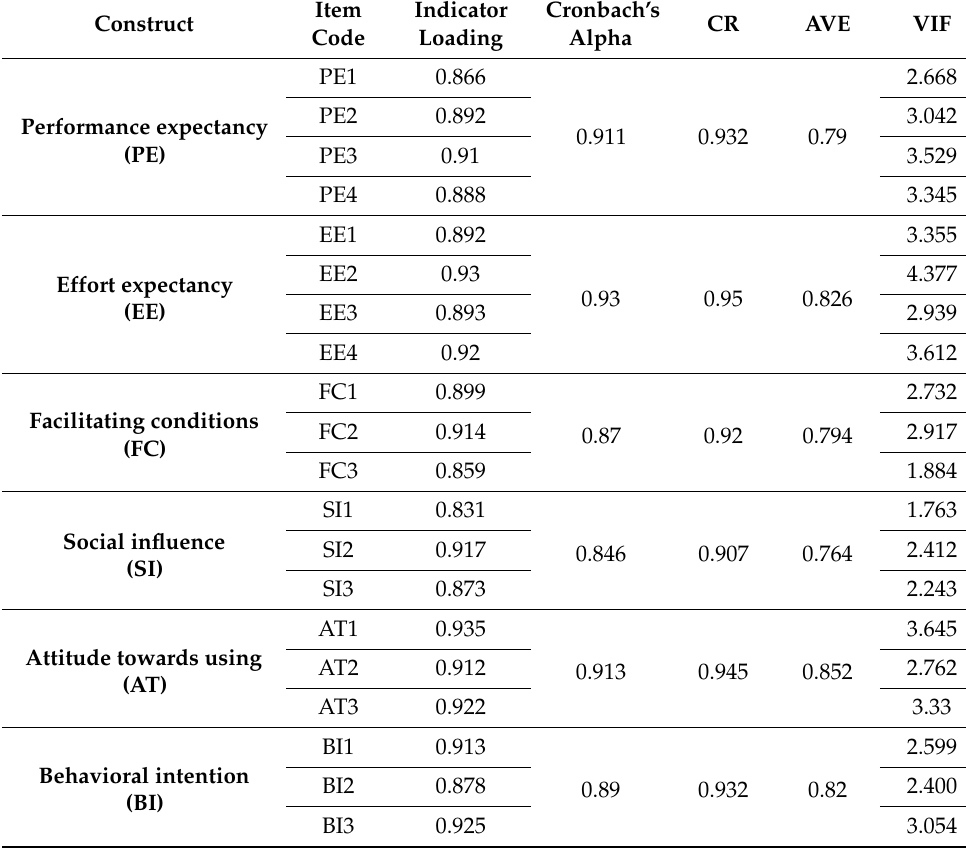
Table 1. Indicator loading and composite reliability of variables and indicators.